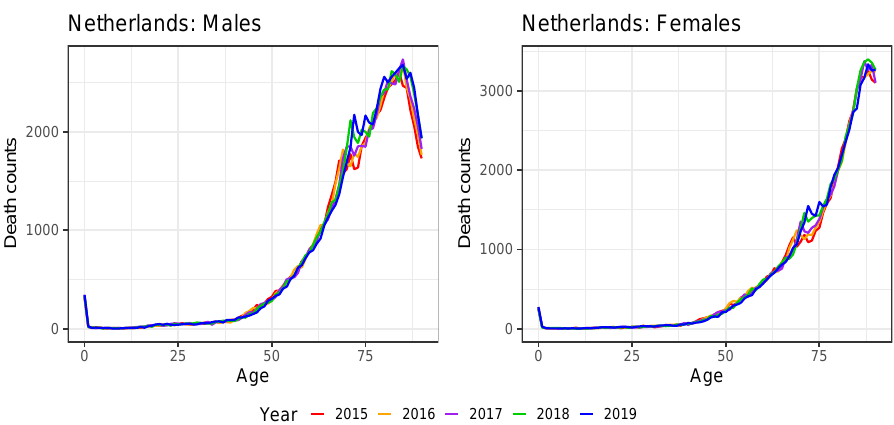
Figure A3. The death counts d x , t of the Netherlands for ages 0–90 and years 2015–2019. Data from HMD.